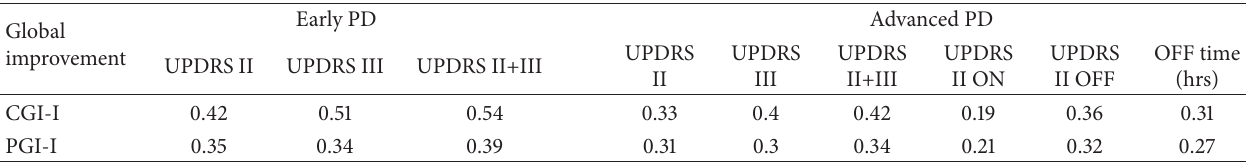
Table 5: Spearman correlation coefficients between PGI-I/CGI-I and changes in UPDRS scores and OFF time in patients with early PD and advanced PD.